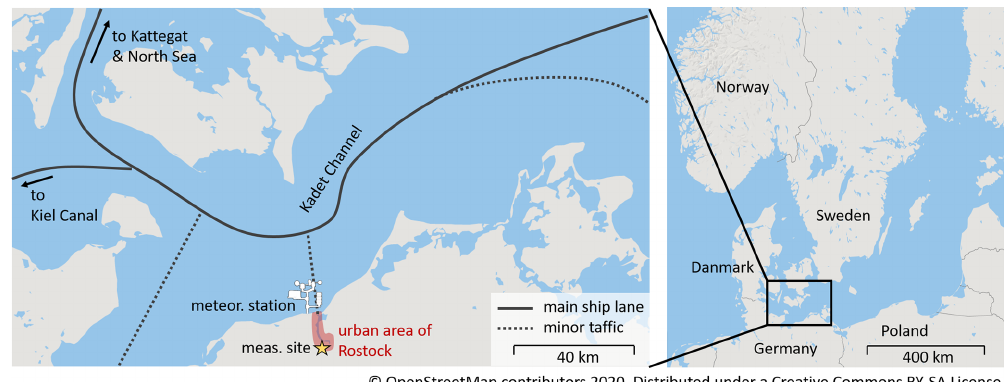
Figure 1. Overview map of the region illustrating the major ship lanes and the position of the measurement site and the meteorological station providing the wind data. A more detailed map can be found in Fig.